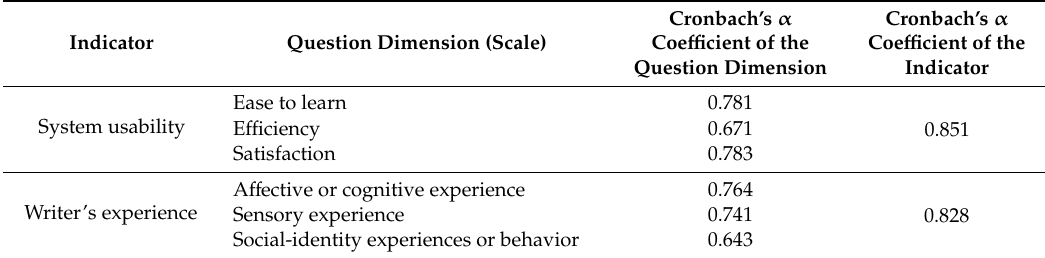
Table15. Cronbach’s α coe ffi cientsofthesixquestiondimensionsofthetwoindicators“systemusability” and “writer’s experience” of the collected questionnaire data.